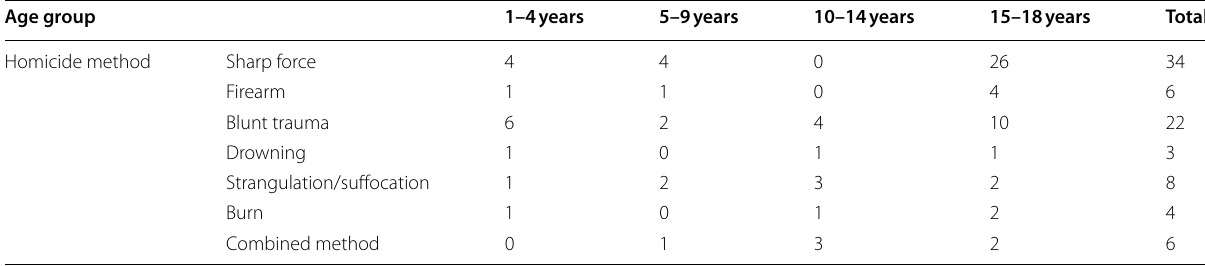
Table 2 Distribution of cases by age group and method of homicide Age